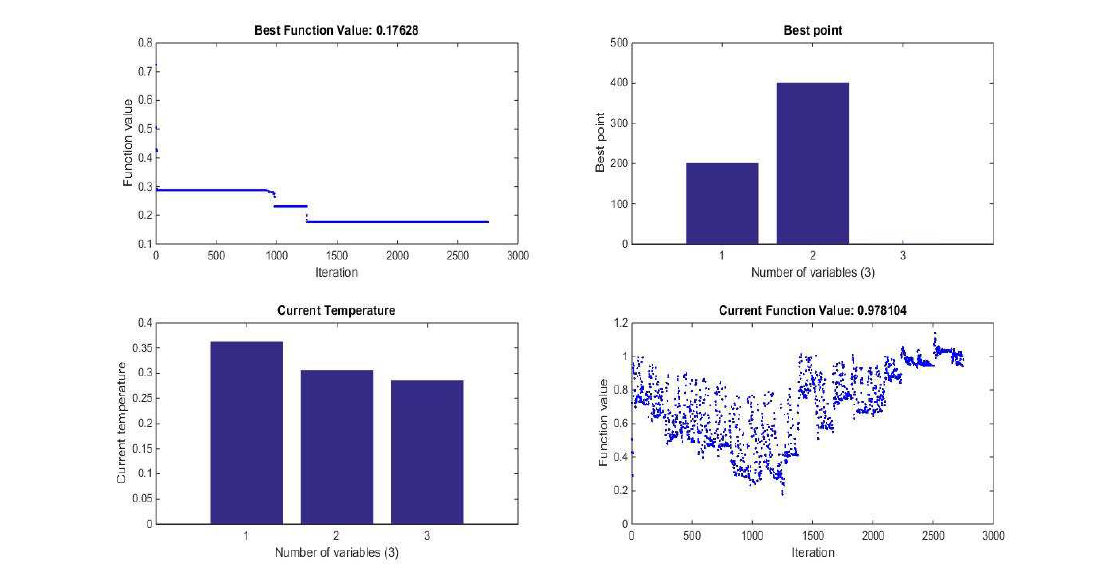
Fig. 14. Performance of Simulated Annealing Algorithm (R